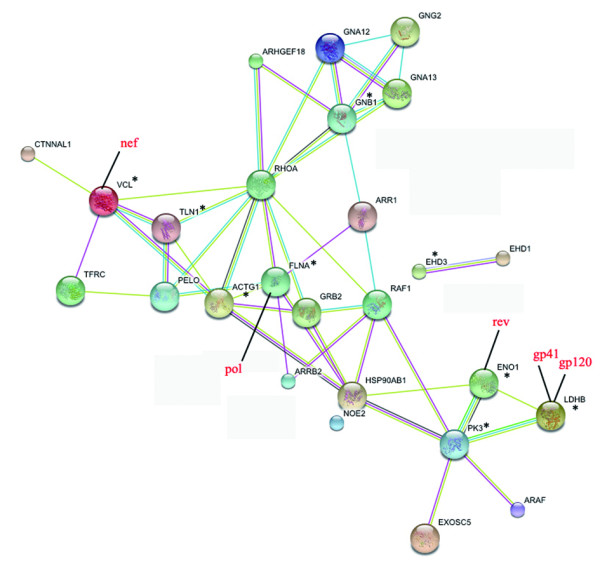
Protein-protein interactions of identified differential proteins with HIV function proteins. Proteins labeled with were differentially expressed proteins identified in our work. Proteins labeled in red character were HIV proteins. The rest proteins were host proteins from the database.